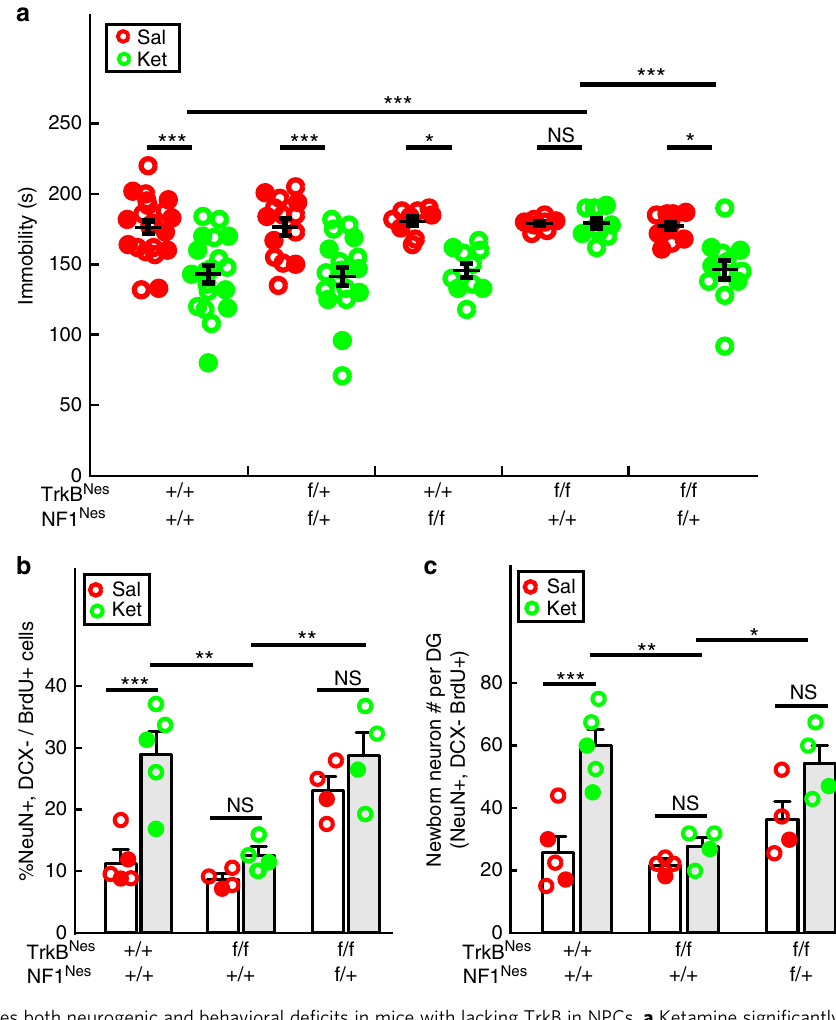
Fig. 8 NF1 ablation rescues both neurogenic and behavioral de fi cits in mice with lacking TrkB in NPCs. a Ketamine signi fi cantly decreased immobility time in the FST in control, NF1 Nes /TrkB Nes double heterozygotes and NF1 Nes mice, but not in TrkB Nes mice. NF1 Nes heterozygous (f/+); TrkB Nes double-mutant mice reversed the impaired response to ketamine, as displayed by a signi fi cant reduction of immobility time in the FST (two-way ANOVA with unweighted mean analysis, Tukey post hoc, *** p = 1.664E − 5 for ketamine-treated TrkB Nes vs control mice; *** p = 3.15E − 4 for ketamine-treated TrkB Nes vs TrkB Nes ; Nf1 Nes f/+; other comparisons were made between saline and ketamine within each genotype group). b Percentage of newborn neurons in ketamine- treated TrkB Nes mice was signi fi cantly decreased compared to ketamine-treated control mice. In contrast, TrkB Nes ; NF1 Nes f/+ mice displayed enhanced mature neuron generation compared to TrkB Nes mice (two-way ANOVA, Tukey post hoc, *** p = 0.0001 for saline vs ketamine in control mice; ** p < 0.01 for ketamine-treated TrkB Nes vs control ( p = 0.0012), or vs TrkB Nes ; NF1 Nes f/+ mice ( p = 0.0081); not signi fi cant for saline vs ketamine in TrkB Nes